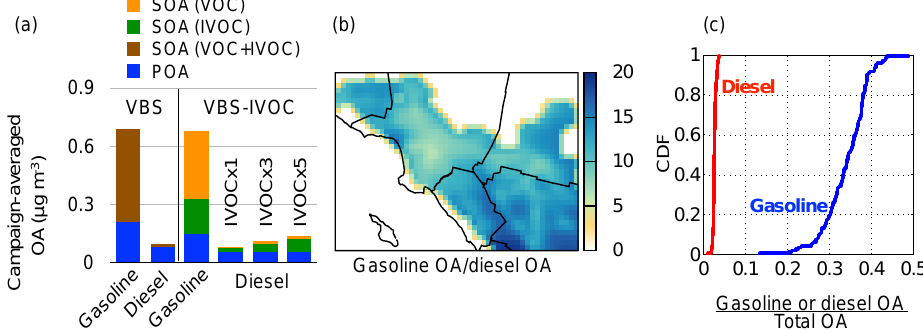
Figure 6. (a) VBS-IVOC predicted campaign-averaged OA concentrations attributable to gasoline and diesel sources at the ground site in Pasadena; the IVOCx1 result for diesel use is from the VBS-IVOC simulation, and the IVOCx3 and IVOCx5 results are from separate sensitivity simulations where IVOC emissions from diesel are scaled by a factor of 3 and 5, respectively, as described in the text. (b) Ratio of gasoline OA to diesel OA over southern California and (c) cumulative distribution functions that show the fractional contribution of gasoline plus diesel OA to total OA in southern California.